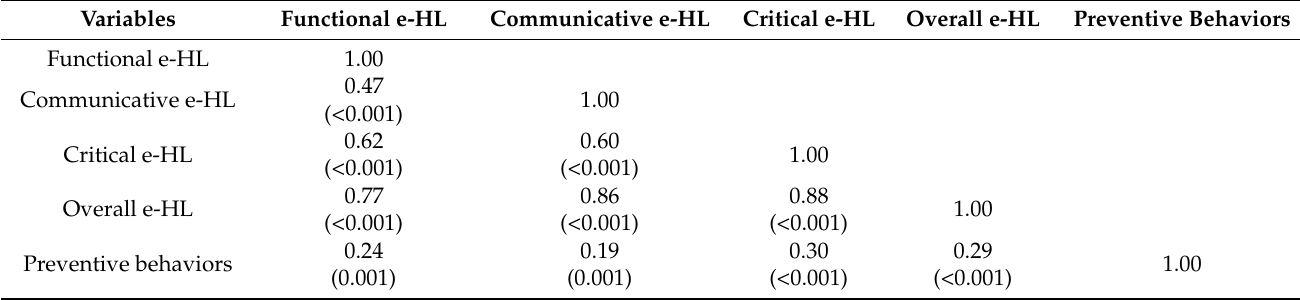
Table 3. Correlations among e-HL and infection-preventive behaviors.